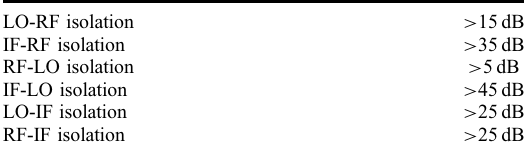
TABLE II Isolation Between the Ports of the Down-converter.